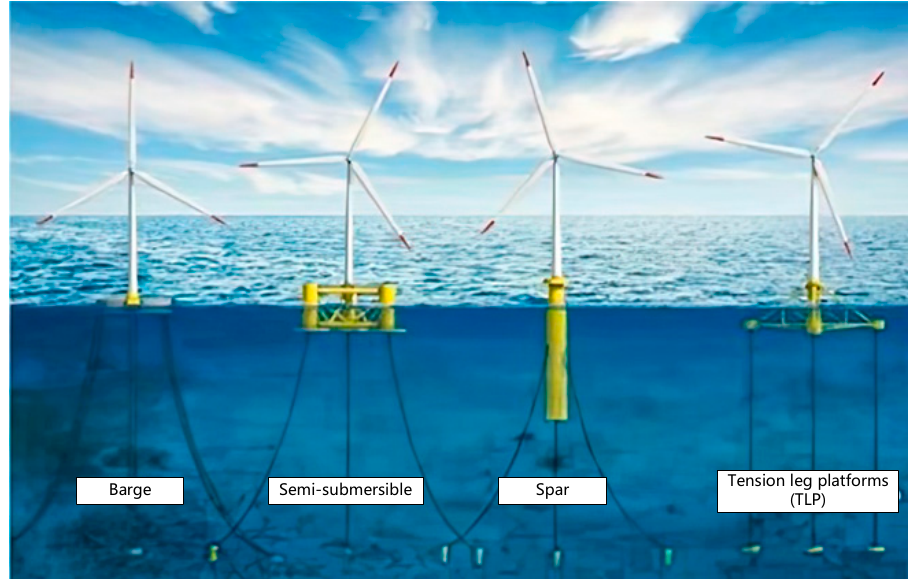
Figure 2. Four types of offshore floating wind power platform structures [21].